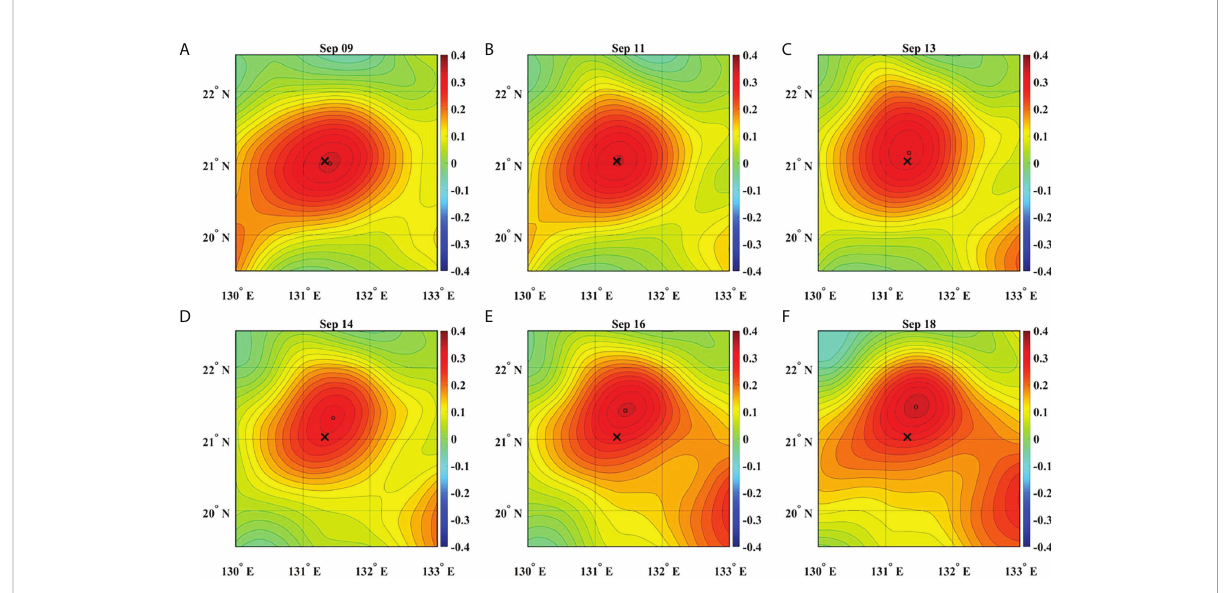
FIGURE 2 Contour map of SSHA satellite data (m), showing a moving mesoscale warm eddy during the VM glider measurement; the glider (black cross) scans near the inner center from September 9 to 13 (top panels, A through C ), and near the outer center from September 14 to 18 (bottom panels, D through F ).